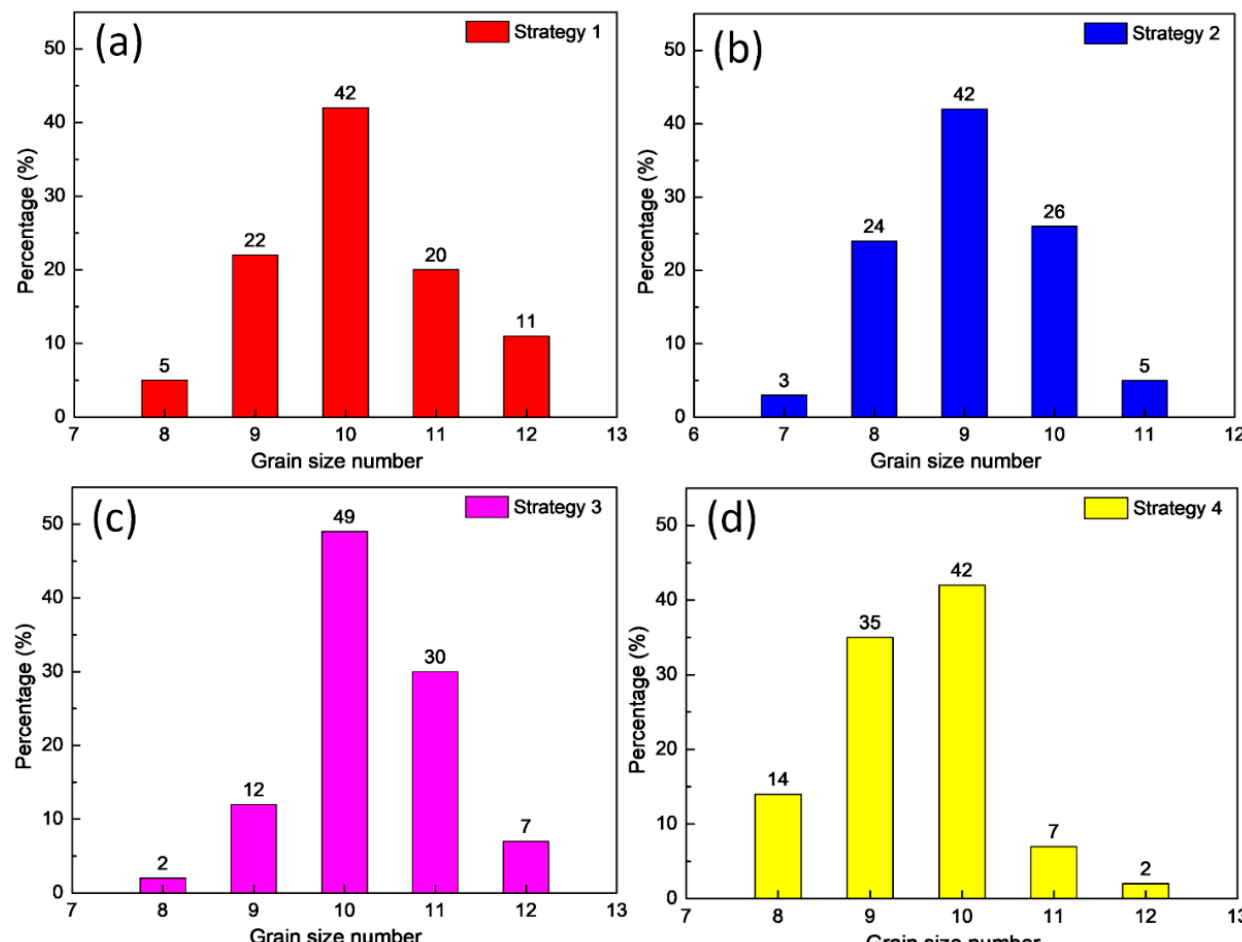
Figure 3. Grain size number distribution following ASTM E112-10 grain size number standard of samples at different WAAM strategies: ( a ) strategy 1, ( b ) strategy 2, ( c ) strategy 3, and ( d ) strategy 4.